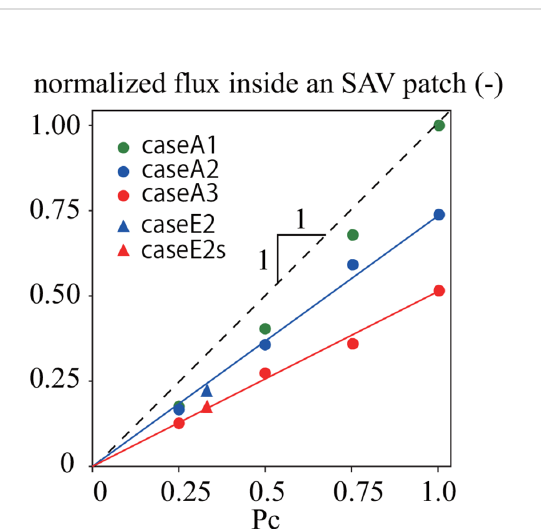
FIGURE 11 Normalized fl uxinsideanSAVpatchfromnumericalsimulationsfor casesE2andE2s,andcasesA1toA3.Blueandredsolidlinesindicate